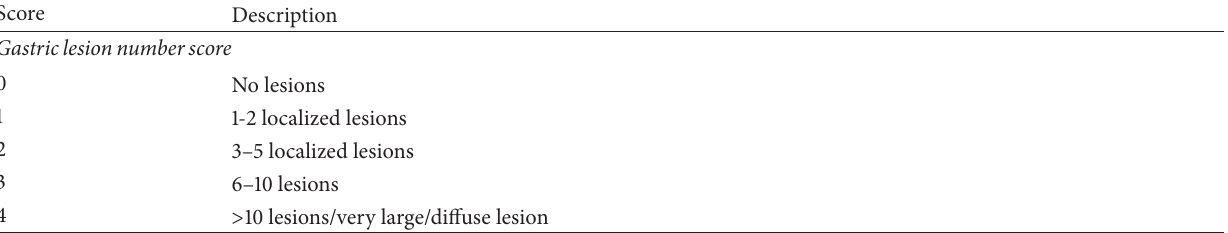
Table 1: GUE score card.